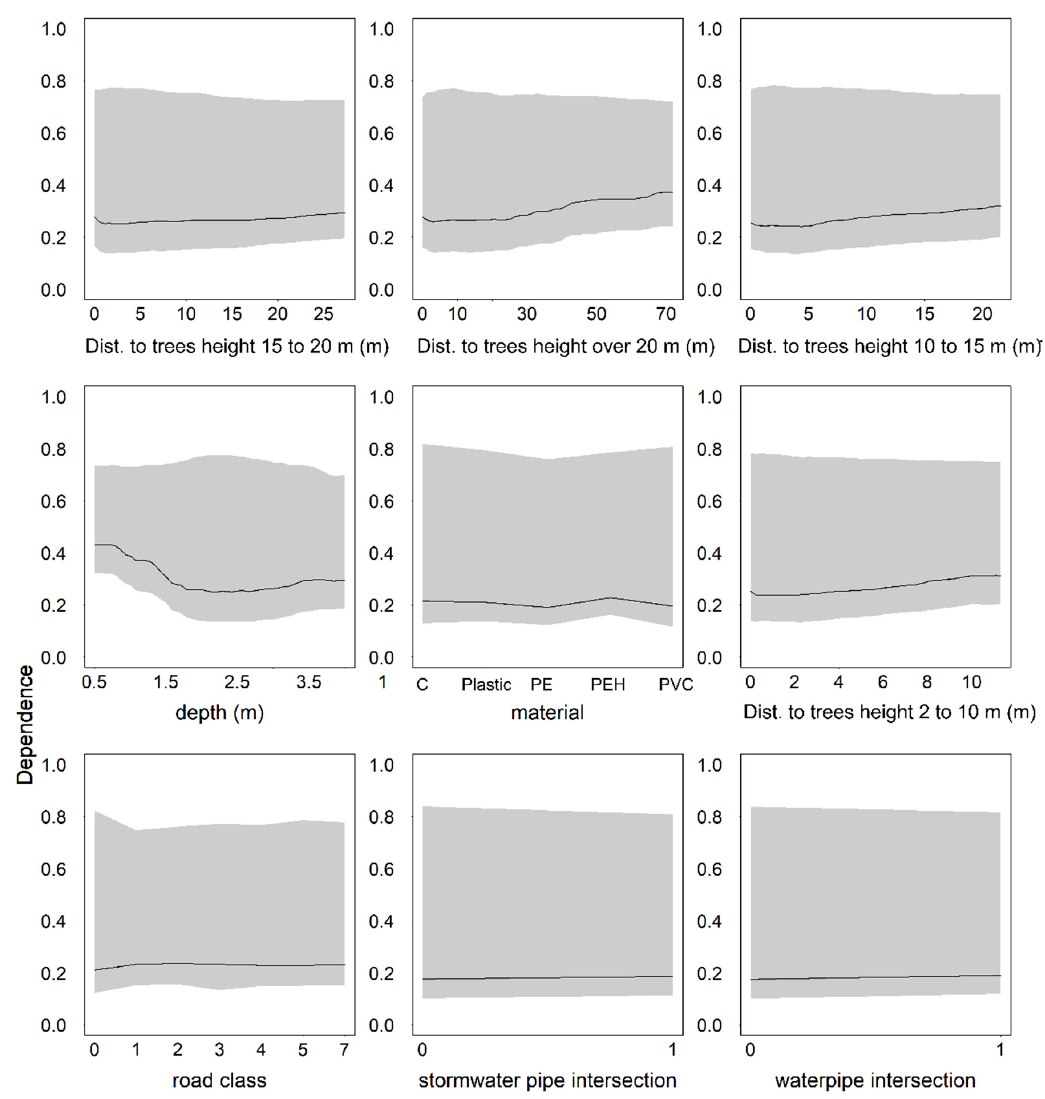
Figure 3. Partial dependence plots for nine of the predictor variables.